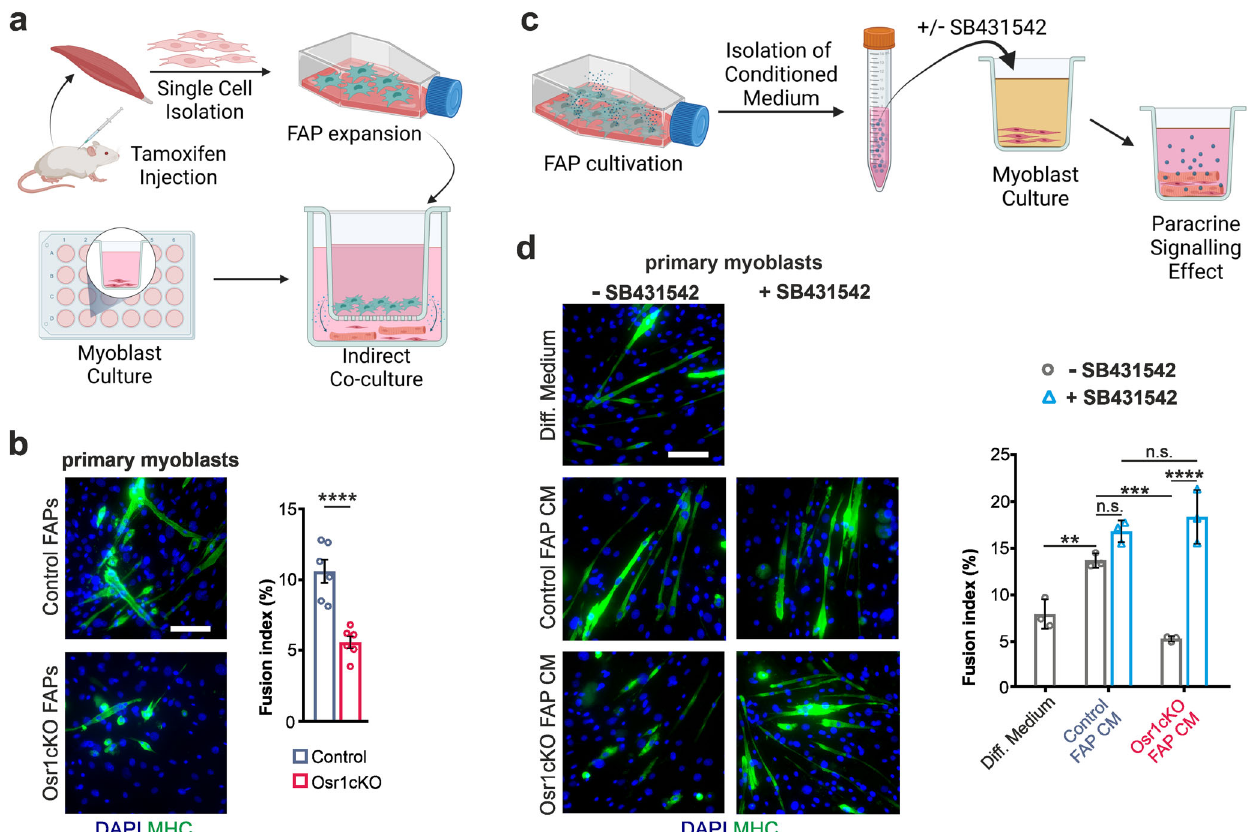
Fig. 6 Osr1cKO FAPs inhibit myogenesis via TGF β signaling. a Schematic representation of the transwell assay. b Immunolabeling for MHC to detect myotube formation from primary myoblasts co-cultured with control or Osr1cKO FAPs; quanti fi cation of fusion index is shown right ( n = 6). c Schematic representation of conditioned medium (CM) assay. d Immunolabeling for MHC to detect myotube formation from primary myoblasts in differentiation medium or differentiation medium supplemented with control or Osr1cKO CM, with or without TGF β pathway inhibitor SB431542; quanti fi cation of fusion index is shown right ( n = 3). Data are mean ± SEM; P ‐ value calculated by two ‐ sided unpaired t test in ( b ) and ANOVA in ( d ); ** p < 0.01, *** p < 0.001, **** p < 0.0001. N ‐ numbers indicate biological replicates (mice per genotype). Scale bars: 100 μ m in ( b , d